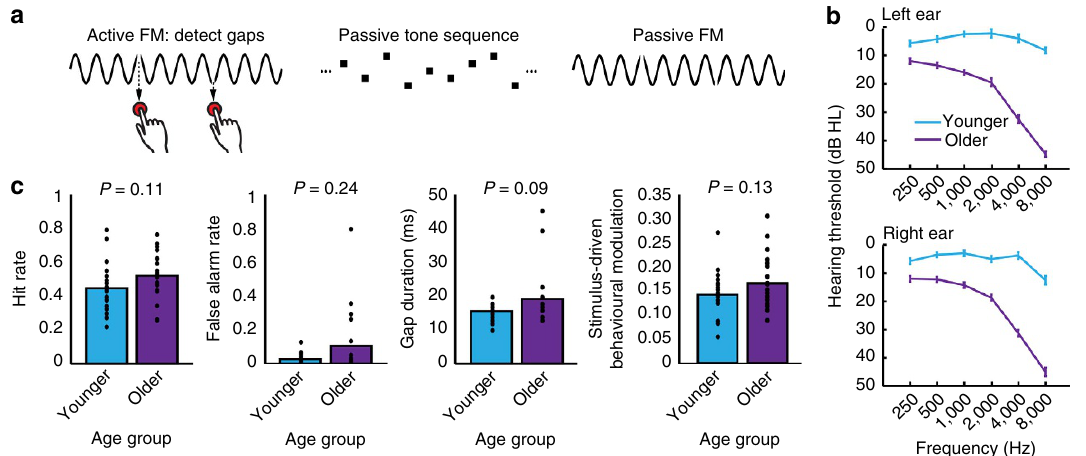
Figure 1 | Entrainment was tested using frequency-modulated stimuli and tone sequences. ( a ) Stimuli and experimental design. Participants were exposed to two blocks of FM stimulation; during an active block, they detected near-threshold gaps, while during a passive block they ignored the same stimuli (in counterbalanced order). Between FM blocks, participants passively listened to an 8-min block of tone stimulation (1,400 tones), with presentation rate and frequency range matched to the rate and modulation depth of the FM stimuli. ( b ) Audiograms for younger (blue) and older (purple) listeners shown separately for the left (top) and right (bottom) ears. Both participant groups had average hearing thresholds better than 20dB up to 2,000Hz. ( c ) Younger and older listeners did not differ significantly according to any behavioural measure.